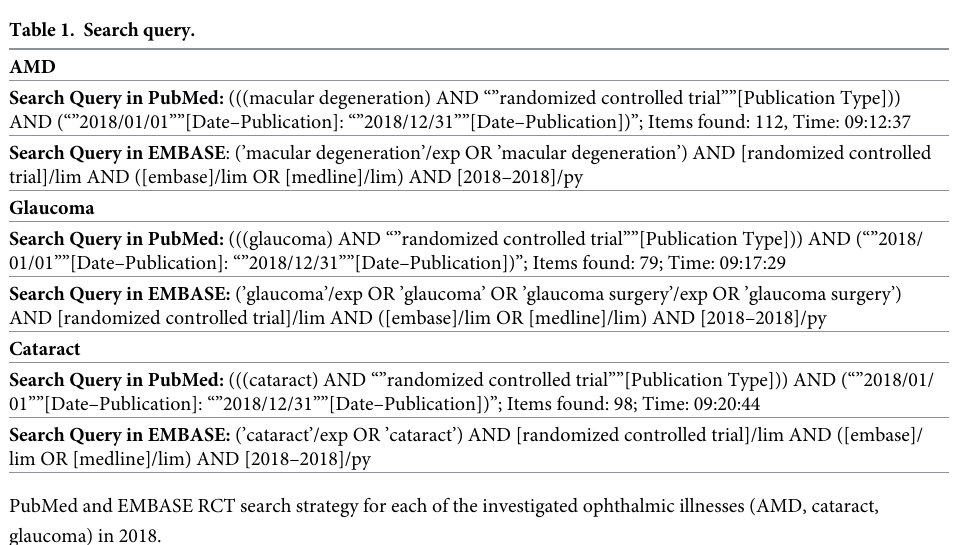
Table 1. Search query.